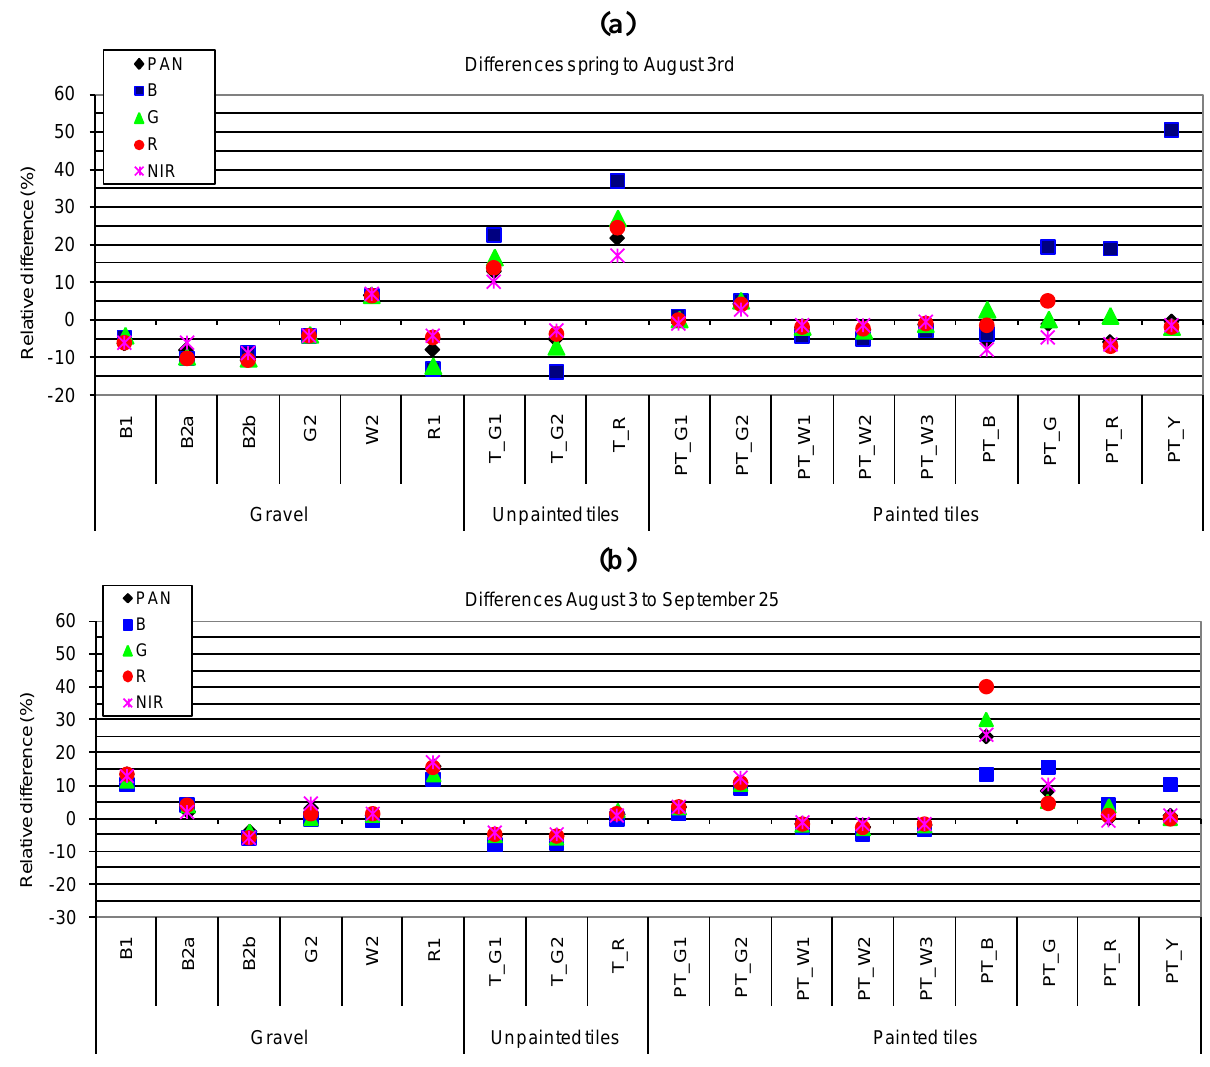
Figure 9. Changes in nadir reflectance of various objects in various channels from (a) May to August and (b) August to September. (Equation 7; the earlier measurement was used as the reference.)